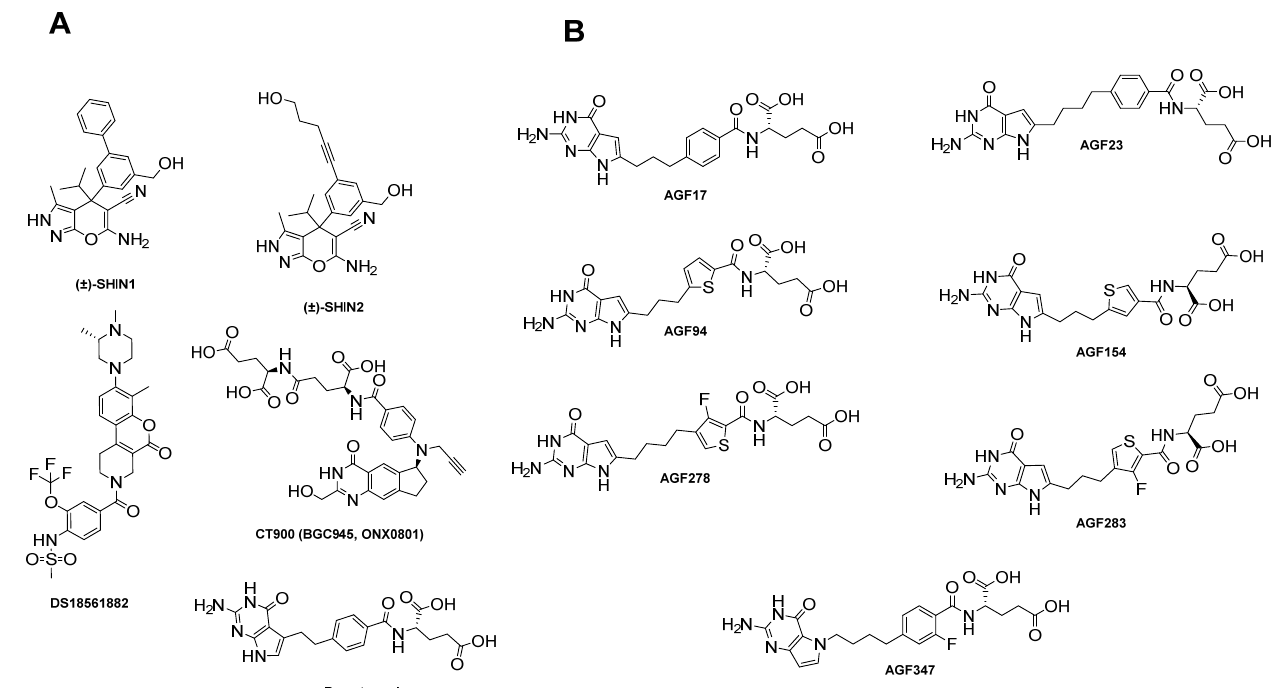
Figure 2. Structures of inhibitors of C1 metabolism. Panel ( A ): structures are shown for the dual SHMT1 and SHMT2 inhibitors SHIN1 and SHIN2 [150,151], the MTHFD2 inhibitor DS18561882 [152], as well as pemetrexed [137] and CT900 (BGC945, ONX0801) [26] (both principally thymidylate syn- thase inhibitors). Panel ( B ): structures are shown for pyrrolo[2,3- d ]pyrimidine GARFTase inhibitors, AGF17 [145], AGF23 [145], AGF94 [147], AGF154 [148], AGF278 [149], and AGF283 [149], as well as the pyrrolo[3,2- d ]pyrimidine antifolate AGF347 [153], which acts as a multitargeted inhibitor of SHMT2 in the mitochondria and of SHMT1, GARFTase, and ATIC in the cytosol. AGF94, AGF154, AGF278, and AGF283 are potent (nanomolar) inhibitors of EOC cell lines (IGROV1, SKOV3, A2780) with a wide (~3000-fold) range of FR α levels and relatively constant PCFT, although the uptake by FR α predominated when both systems were present [14,149]. In IGROV1 cells, FR α knockdown (~95%) had a modest impact on in vitro drug efficacy, establishing transport redundancy for pyrrolo[2,3- d ]pyrimidine antifolates such as AGF94 by the PCFT and FR α [14,149]. For AGF94, this finding was extended in